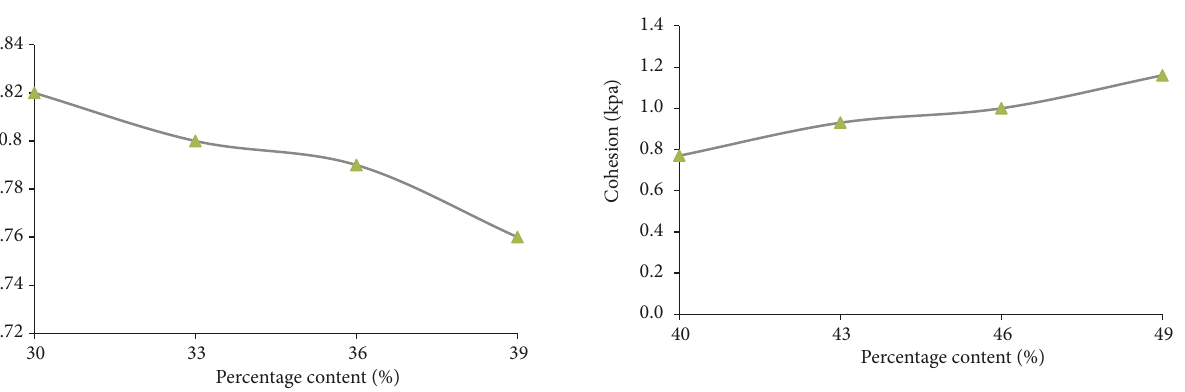
Figure 8: Influence of standard sand on cohesion.